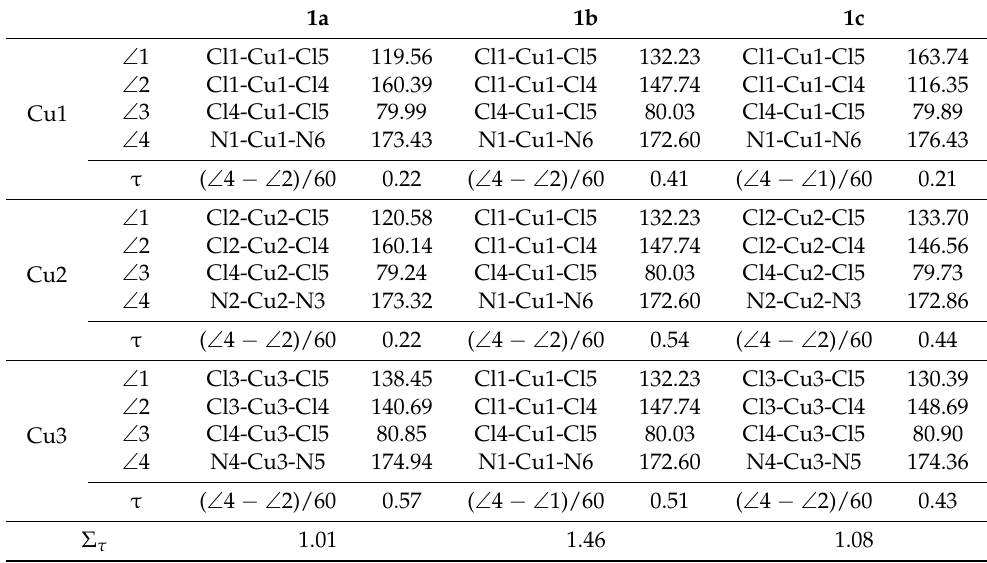
Table 3. Selected bond angles ( ◦ ) and calculated τ values for 1a – 1c